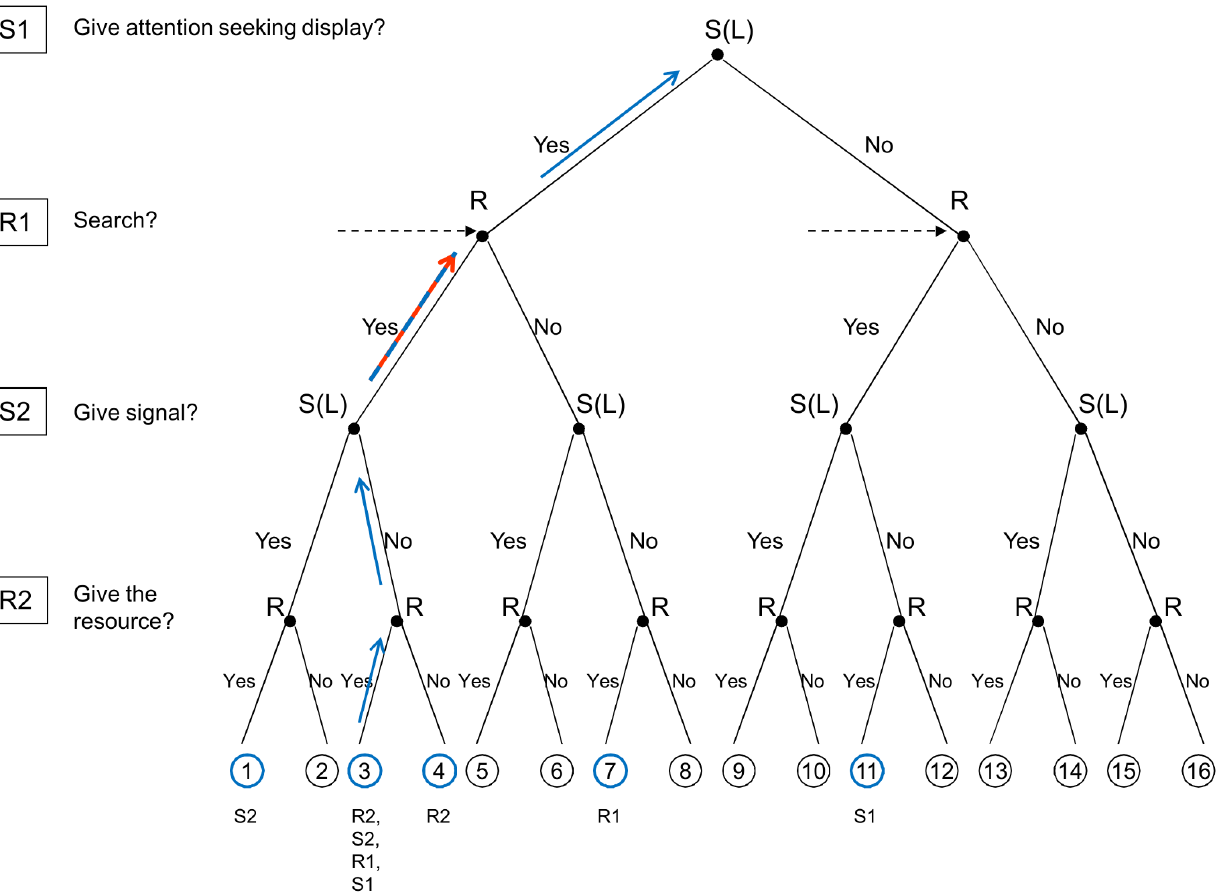
Fig 4. The logic of backward induction for low quality signallers when it is worth for the receiver to give the resource to low quality signallers in the absence of high quality ones. Arrows show the progression, coloured circles show the compared nodes and the label(s) below the circles show the step at which the given nodes are compared. We are looking for a pair of ESS strategies that lead to node 3 in case of low quality signallers (i.e. where receivers search and they give the resource to low quality signallers in the absence of high quality ones, however low quality signallers still do not give signals of quality). First step: node 3 vs. node 4 from the receiver ’ s point of view (R2). Second step: node 1 vs. node 3 from the signaller ’ s point of view (S2). Third step: nodes 1 and 5 vs. nodes 3 and 7 weighted by the ratio of high to low quality individuals from the receiver ’ s point of view (R1; the reason behind comparing several nodes is the informational uncertainty the receiver facing at this point). Fourth step: node 3 vs. node 11 from the signaller ’ s point of view